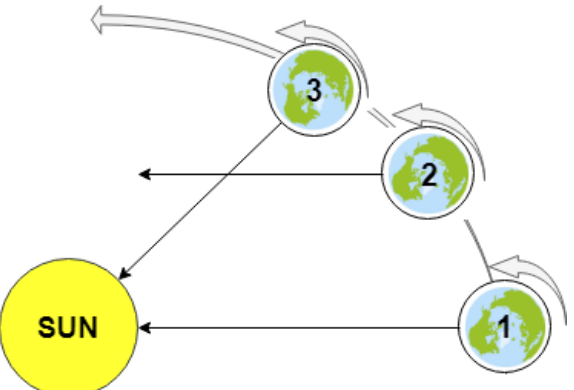
Figure 1. Stellar day vs. True Solar day: ( 1 ) time on Earth is exactly noon; ( 2 ) Earth completed a full rotation about its axis, but it is not noon yet due to the Earth revolution around the Sun; and ( 3 ) true noon of the following day.